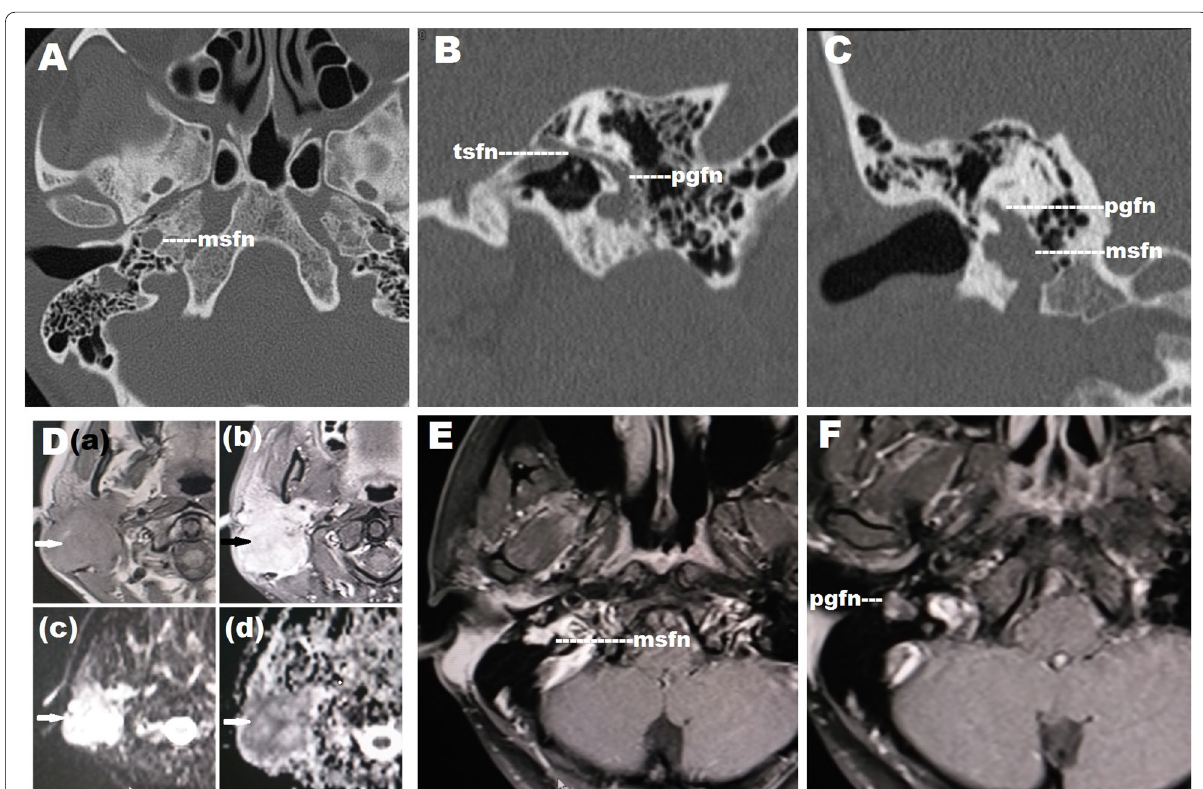
Fig. 2 HRCT and CE-MRI findings of adenoid cystic tumor of right parotid (arrow) in a 26-year-old female patient showing perineural extension along the facial nerve. A HRCT scan in axial section showing the enlarged canal for mastoid segment of facial nerve (msfn) . B HRCT in oblique sagittal section showing enlarged posterior genu of facial nerve (pgfn) with 3 mm extension into tympanic segments (tsfn) of facial nerve. C HRCT in oblique coronal section showing enlarged posterior genu (pgfn) and mastoid segments (msfn). D (a, b, c, d). (a) Showing the parotid lesion as isointense on T1WI, (b) enhancing on post contrast T1WI, (c) hyperintense on DWI, and (d) hypointense on ADC maps indicating restriction of diffusion. E Axial contrast enhanced MRI showing enhancement of mastoid segment of facial nerve (msfn). F Axial contrast enhanced MRI showing patchy enhancement with thickening of the posterior genu of facial